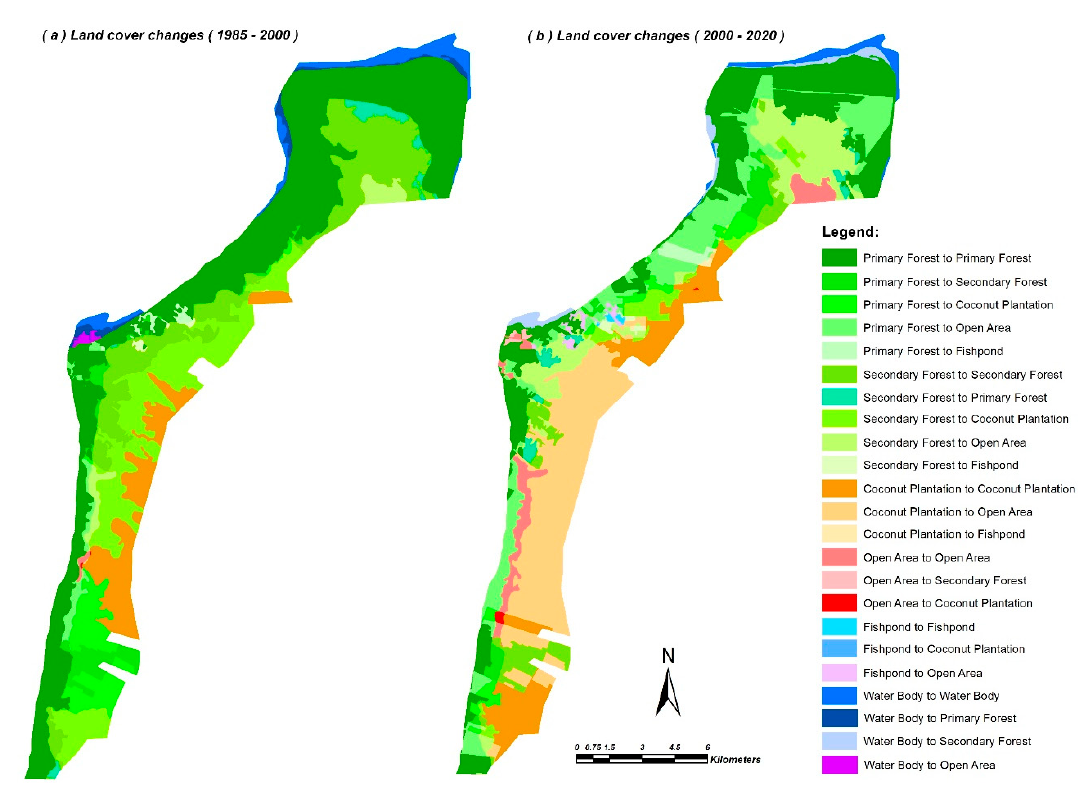
Figure 5. Map of land cover change in the ATPF 1985–2000 and 2000–2020 periods.